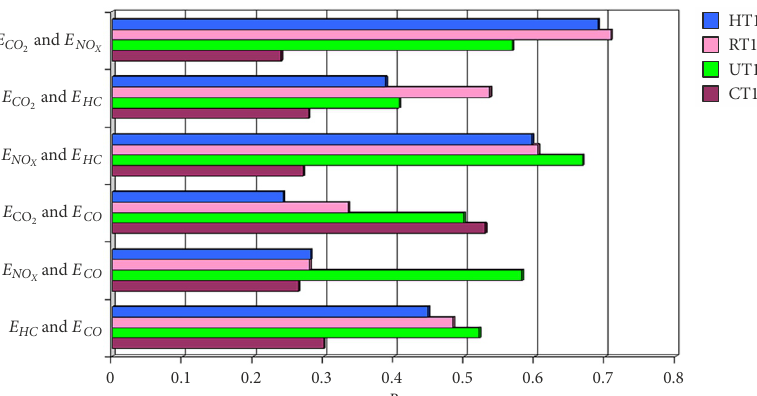
Figure 20. Coefficient of Spearman’s rank correlation R between the emission intensity of specific pollutants